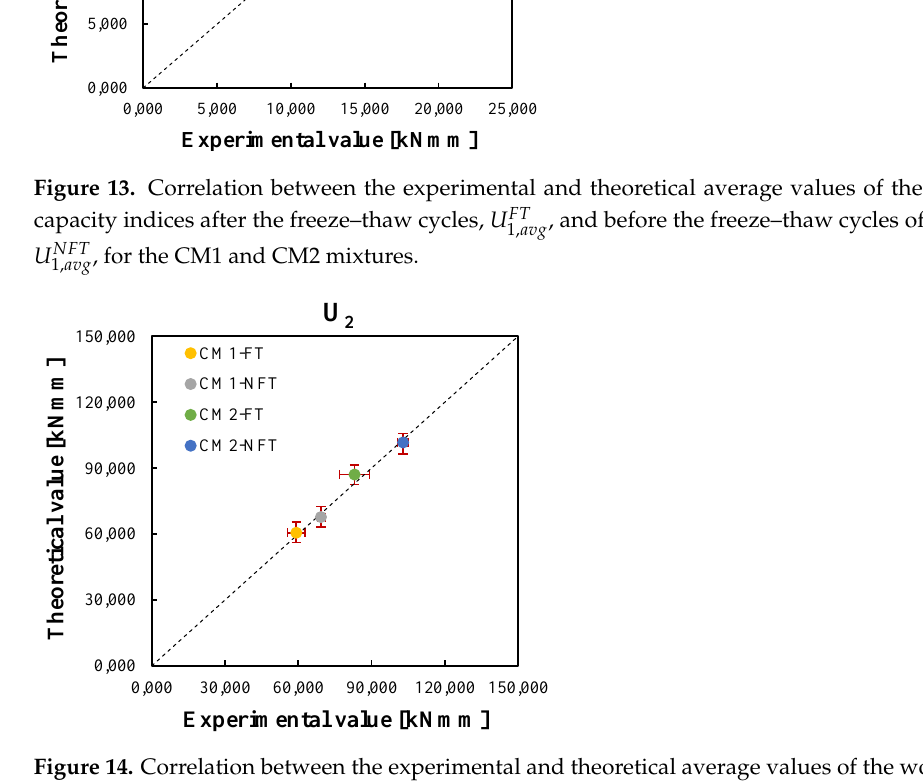
Figure 14. Correlation between the experimental and theoretical average values of the working ca- pacity indices after the freeze – thaw cycles, 𝑈 2,𝑎𝑣𝑔𝐹𝑇 , and those before the freeze – thaw cycles of Ref. [42], 𝑈 2,𝑎𝑣𝑔𝑁𝐹𝑇 , for the CM1 and CM2 mixtures.